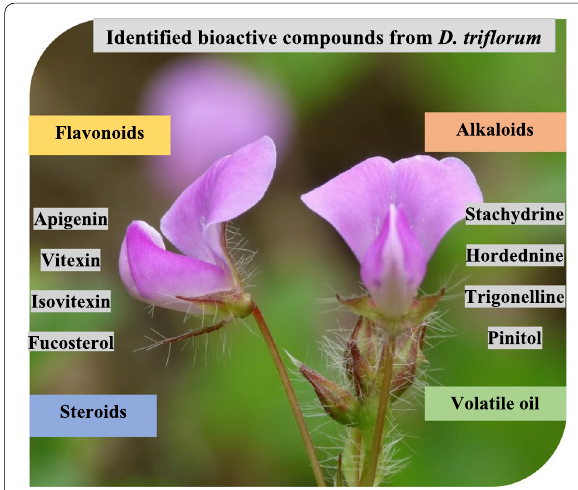
Fig. 5 Schematic diagram represents the phytoconstituents present in Desmodium